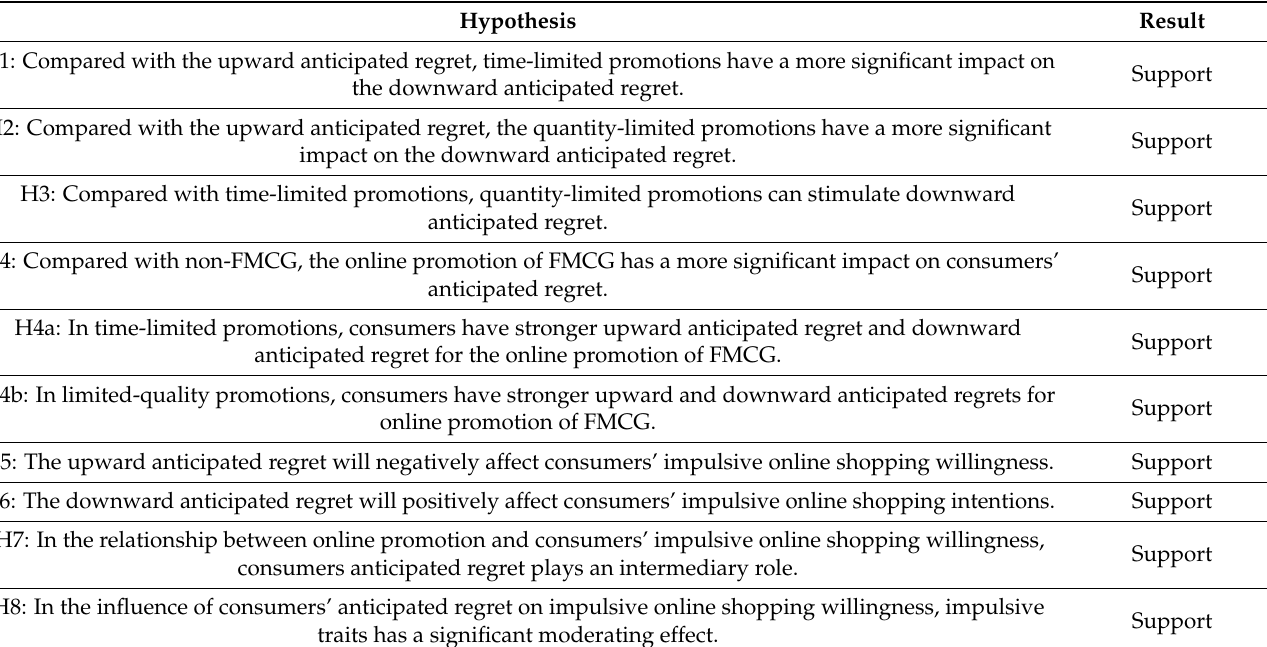
Table 18. Summary of hypothesis test